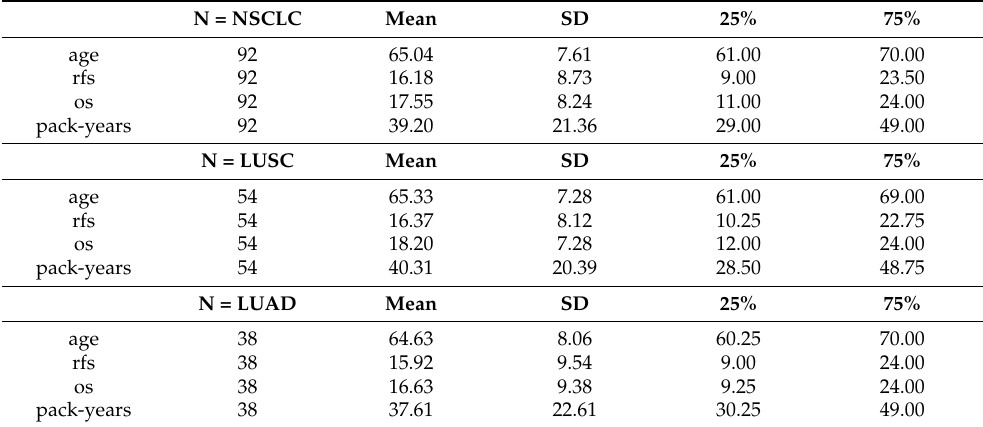
Table 2. Characteristic of patients including age, overall survival (OS), recurrence-free survival (RFS), and pack-years. Non-small cell lung cancer (NSCLC), squamous cell carcinoma (LUSC), adenocarcinoma